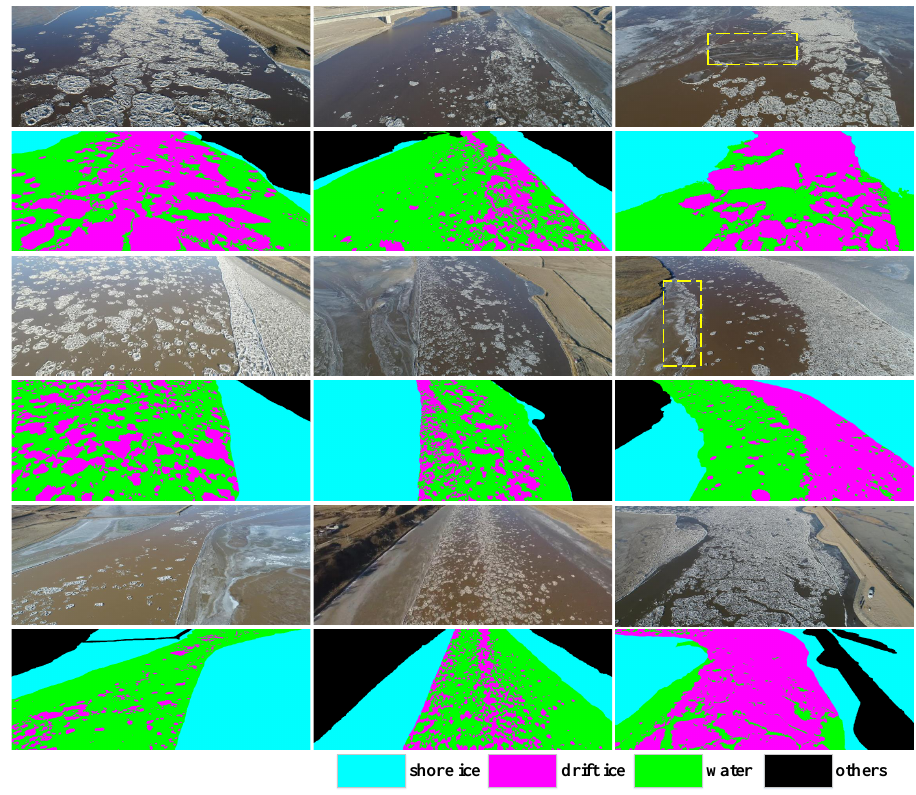
Figure 3. Some typical river ice images and their corresponding annotation